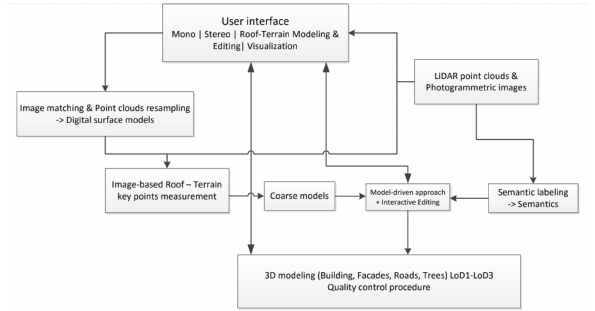
Figure 2. Overall workflow of the project